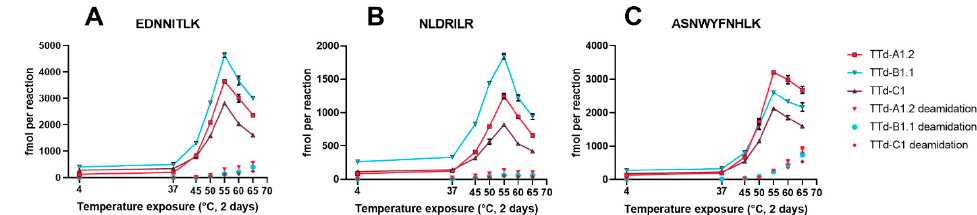
Figure 3. Absolute quantification of ( A ) EDNNITLK, ( B ) NLDRILR, and ( C ) ASNWYFNHLK formed by partial digestion (at t = 20 h) with cathepsin S of tetanus toxoids (TTd-A1.2, TTd-B1.1 and TTd-C1) that were pre-exposed to elevated temperatures. Connected points indicate the sum of the native peptides and their deamidated forms, single points represent the deamidated forms only. Error bars represent the SD of three temperature exposed aliquots of the same TTd batch.